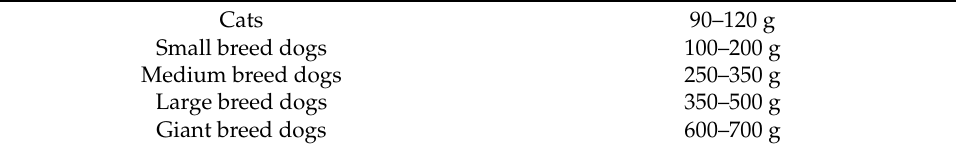
Table 1. Mean birth weight of dogs and cats